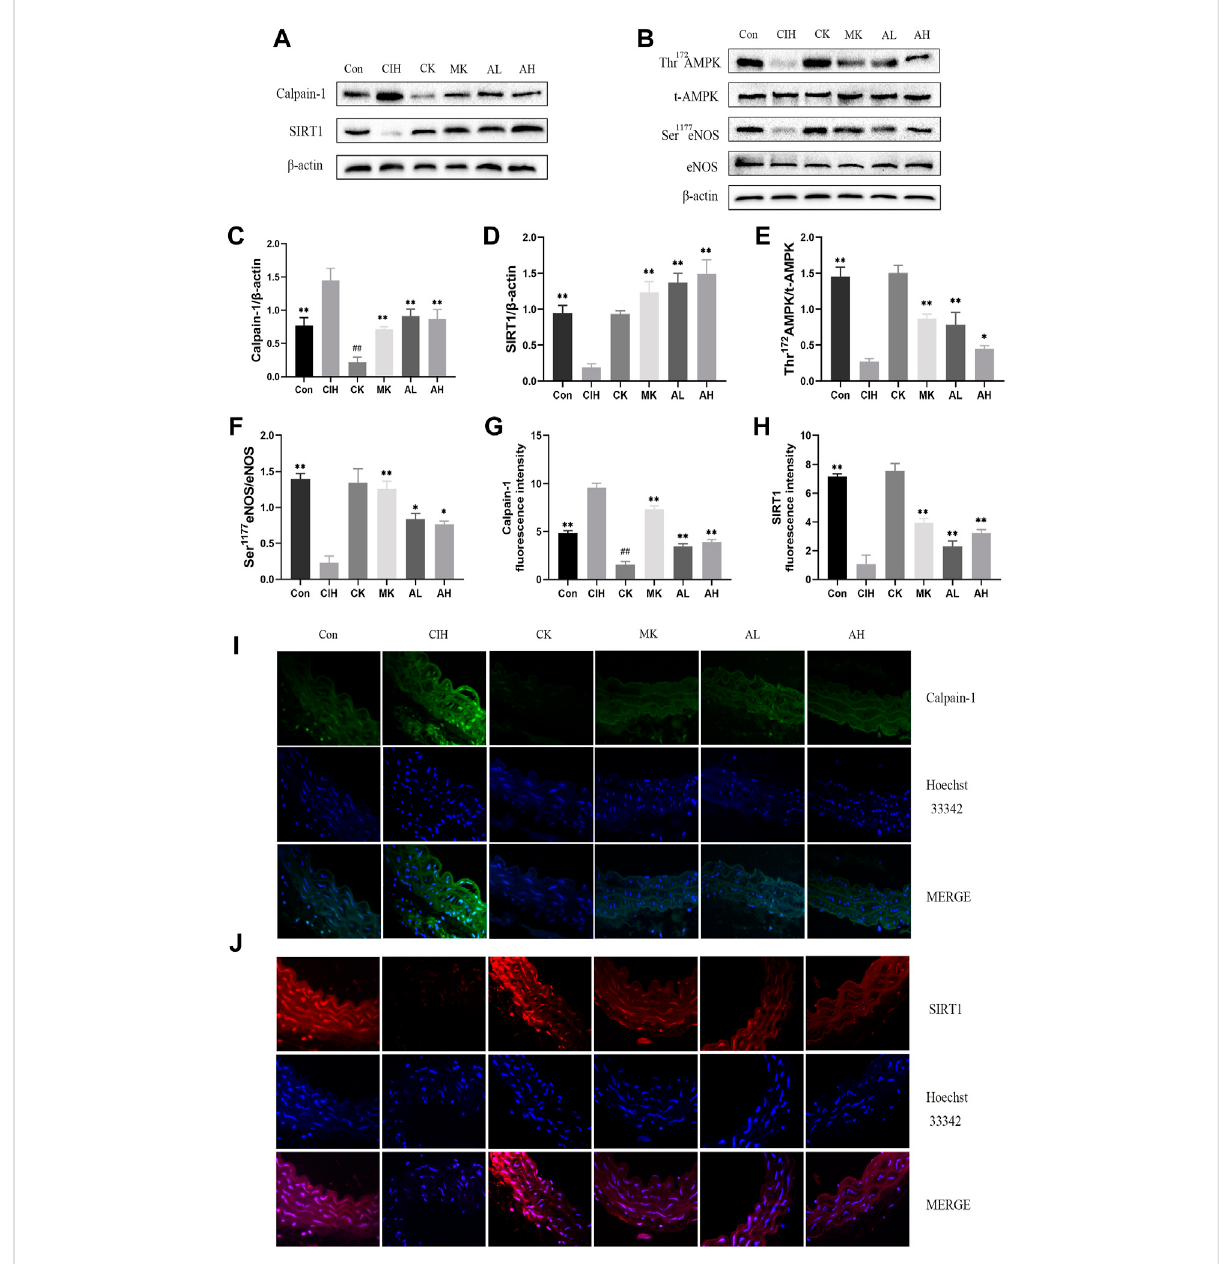
FIGURE 4 EffectsofAs-IVand Capn1knockoutontheSIRT1/AMPK/eNOSsignalingpathwayinCIH-inducedmice. (A – F) Western blotanalysisofcalpain- 1, SIRT1, Thr 172 AMPK phosphorylation, t-AMPK, Ser 1177 eNOS phosphorylation and eNOS protein expression in all groups with quanti fi cation ( n = 3). (G – J) Representative fl uorescenceimagesand fl uorescenceintensityofcalpain-1andSIRT1inallgroupsofaorticsections(×400magni fi cation; n